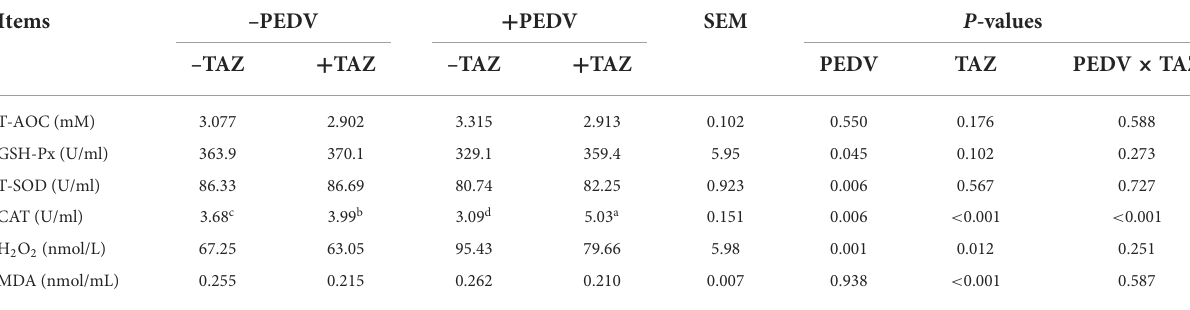
TABLE 4 The effect of tannic acid-chelated zinc on plasma antioxidant capacity in PEDV-infected piglets.